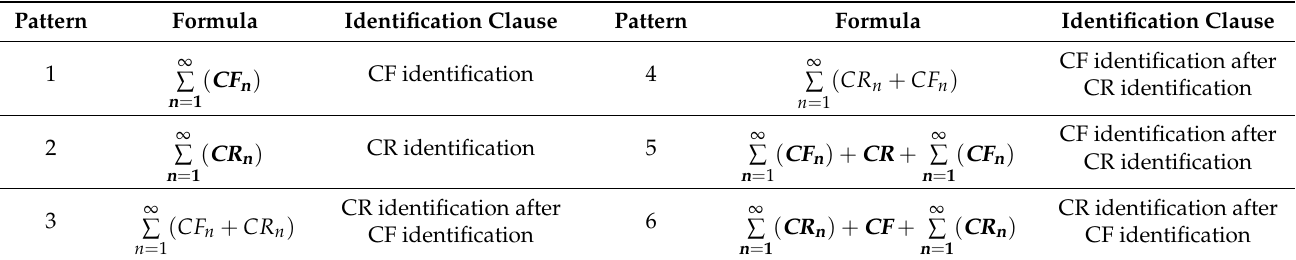
Table 7. Types of identifiable clause patterns.